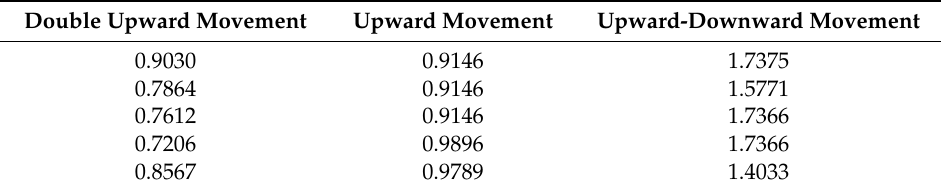
Table 2. Average values obtained from the approximation coefficients for each of the signals related to each arm movement. In column one, it is possible to see the average value of five samples, or vectors, related to the double upward movement, and so on in every column. In this sense, this behavior is used to generate control words which represent each arm movement.